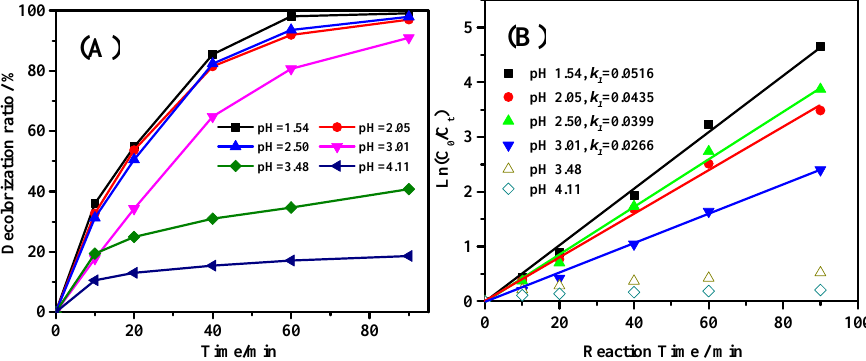
Figure 4. Effect of pH value on the degradation of ARG (C 0 = 50 mg/L) ( A ), and the first order simulation of the data ( B ).